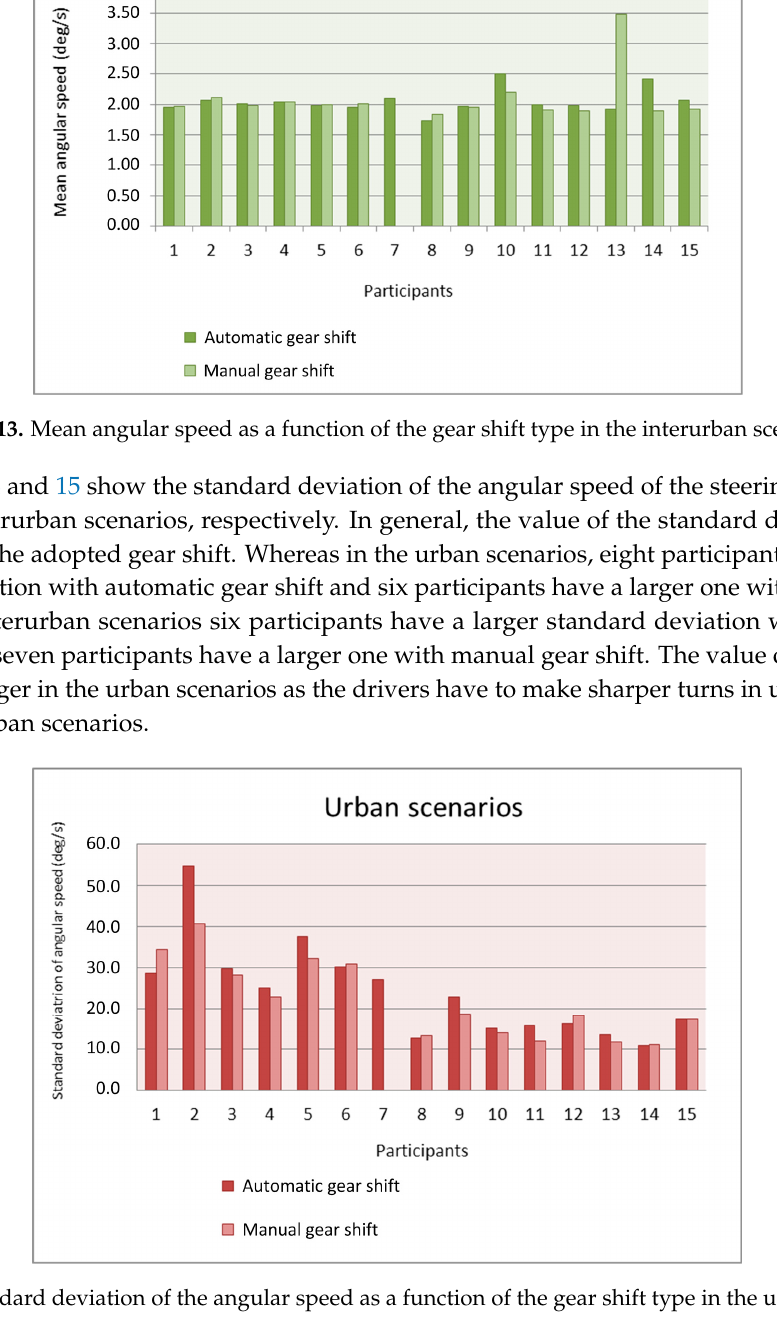
Figure 12. Mean angular speed as a function of the gear shift type in the urban scenarios.